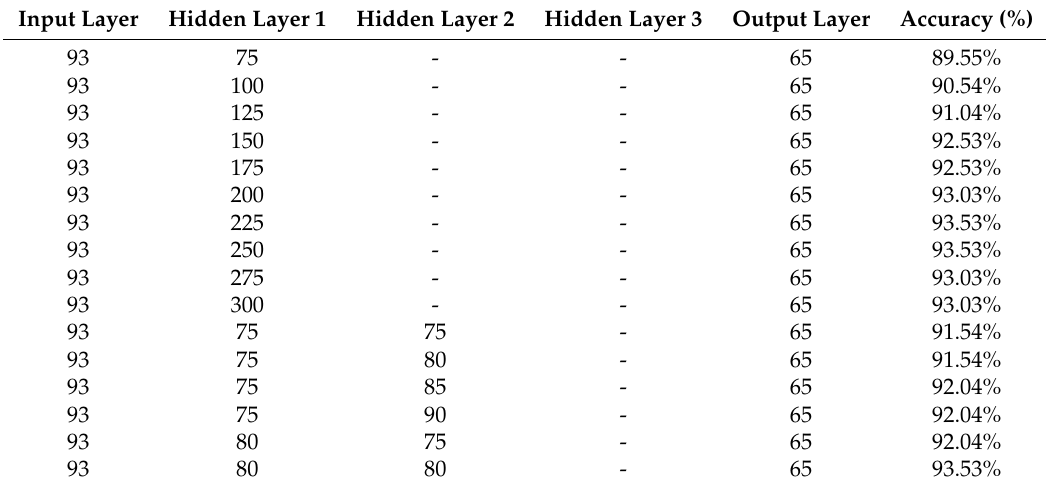
Table 1. Deep neural network performance with varying numbers of neurons within a hidden layer, as well as with different numbers of hidden